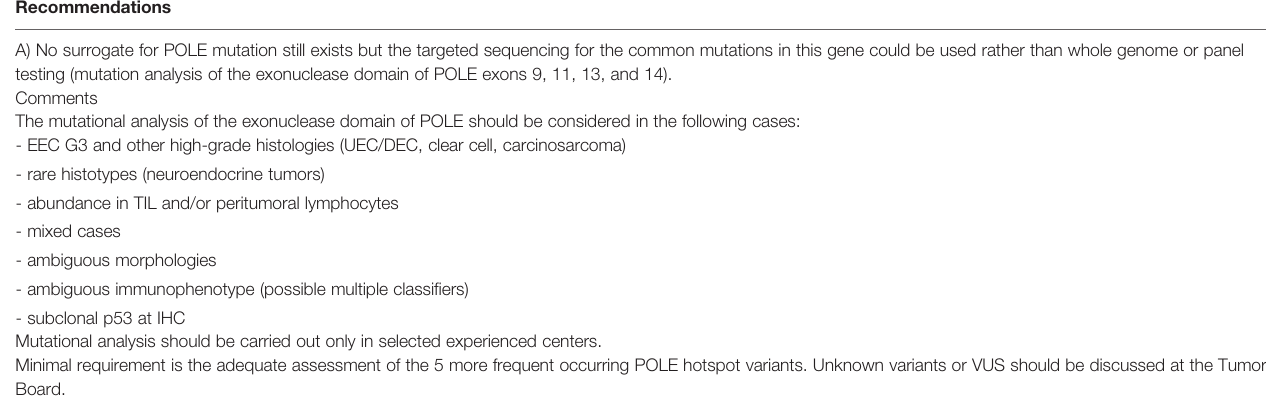
TABLE 1 | POLE: recommendations and comments from the working group.